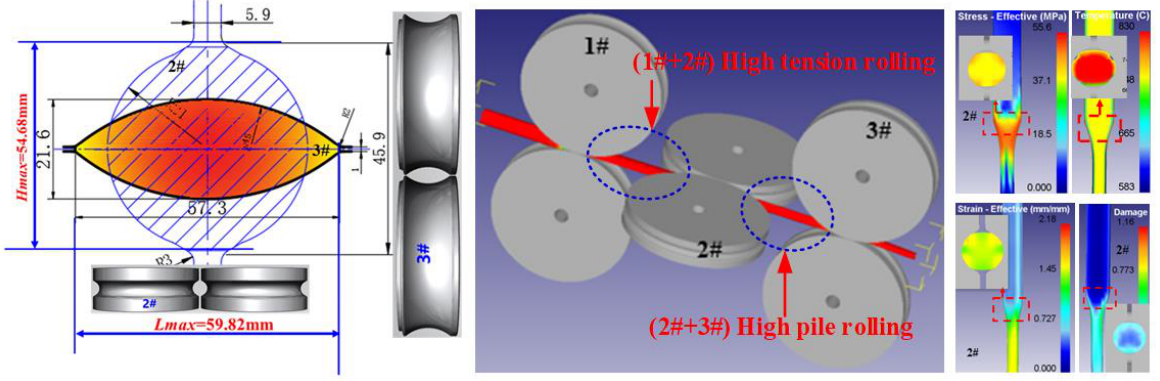
Figure 11. Simulation of rolling state of the 2# stand.